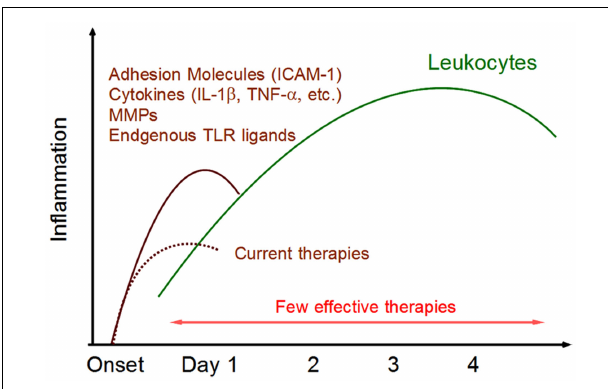
FIGURE 1 | Post-ischemic inflammation in the brain. Within 24h after ischemic stroke onset, various inflammatory mediators are expressed in ischemic brain tissue. ICAM-1 promotes leukocytes infiltration. Cytokines activate infiltrating leukocytes and directly induce ischemic injury in brain cells. Matrix metalloproteinases (MMPs) alter the permeability of epithelial cells and are implicated in BBB breakdown. EndogenousTLR ligands (DAMPs) are released from necrotic brain cells and activate infiltrating immune cells.These inflammatory mediators trigger post-ischemic inflammation by infiltrating leukocytes.There are currently few effective therapies for this phase of leukocyte